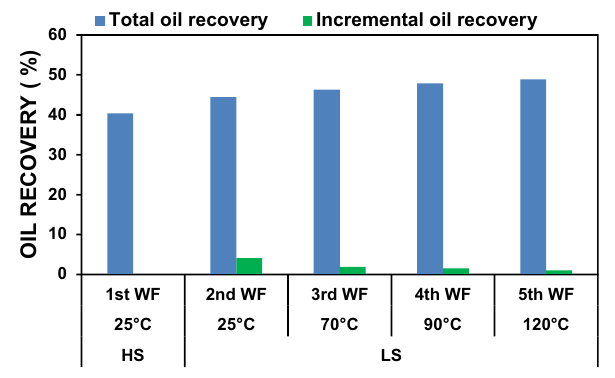
Fig. 13 Oil recovery test results for sandstone column#2 (sand + kao-